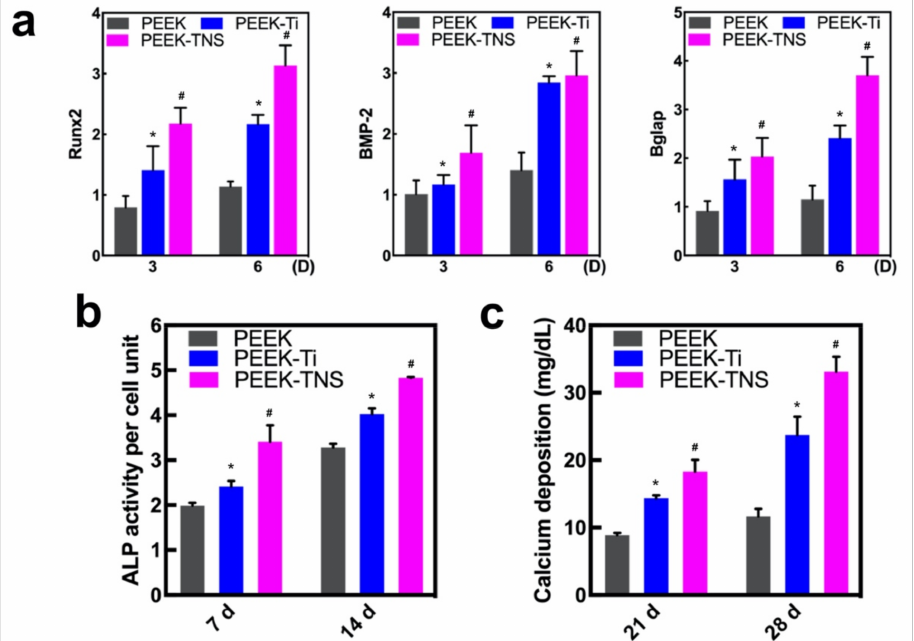
Figure 6. Osteogenic differentiation of rBMMSCs on PEEK, PEEK-Ti, and PEEK-TNS. ( a ) RT-qPCR of the osteogenic-related gene expressions. ( b ) ALP activity levels of days 7 and 14. ( c ) Mineralization levels of 21 and 28 days. (* represents p < 0.05 when PEEK-Ti is compared with PEEK; # represents p < 0.05 when PEEK-TNS is compared with